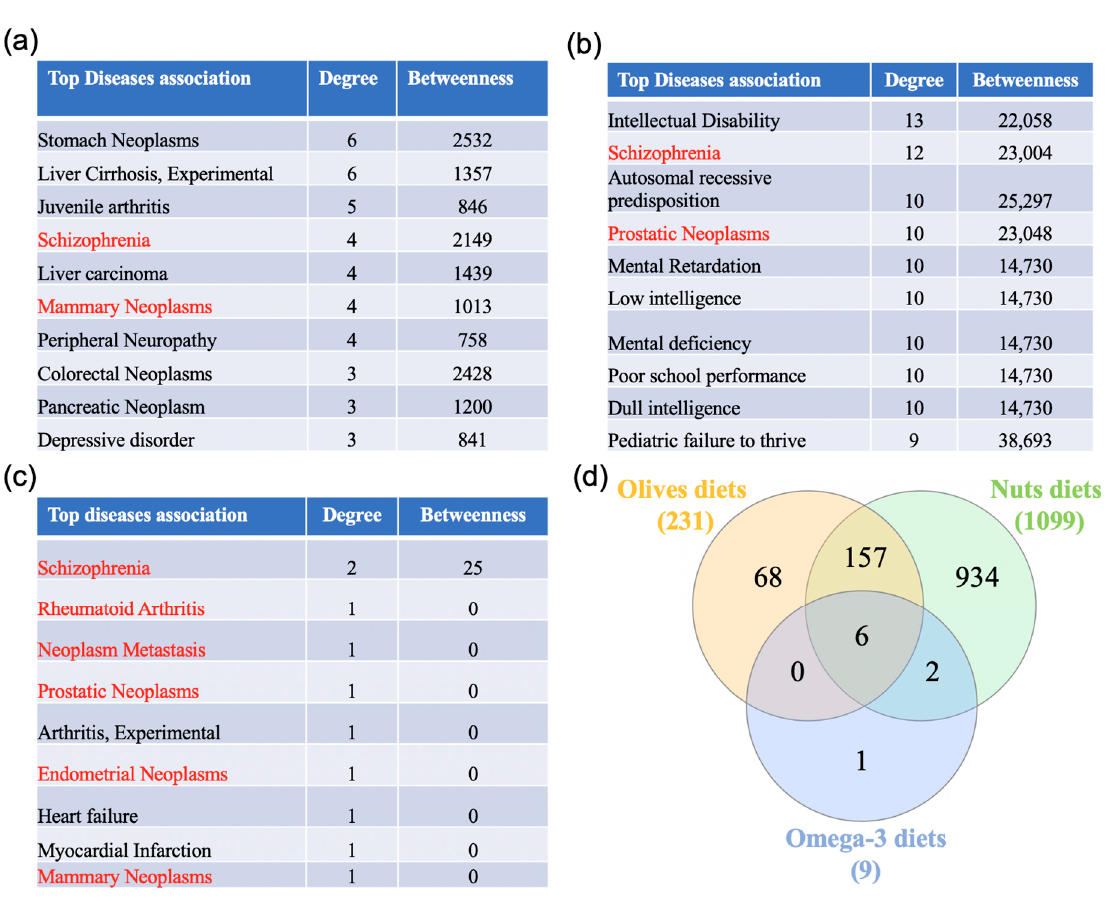
Figure 6. Disease association analysis. ( a – c ) The diet genes lists were uploaded to https://www.networkanalyst.ca/NetworkAnalyst/faces/home.xhtml to perform the disease association analysis. The diseases were ranked by decreasing degree followed by decreasing betweenness, and the top 10 diseases obtained from the olive-, nuts, and omega-2-supplemented diets are presented in ( a ), ( b ), and ( c ), respectively. ( d ) A Venn analysis was performed to determine the diseases shared between the different types of Mediterranean diets. The associated diseases in red are shared between the three supplements.